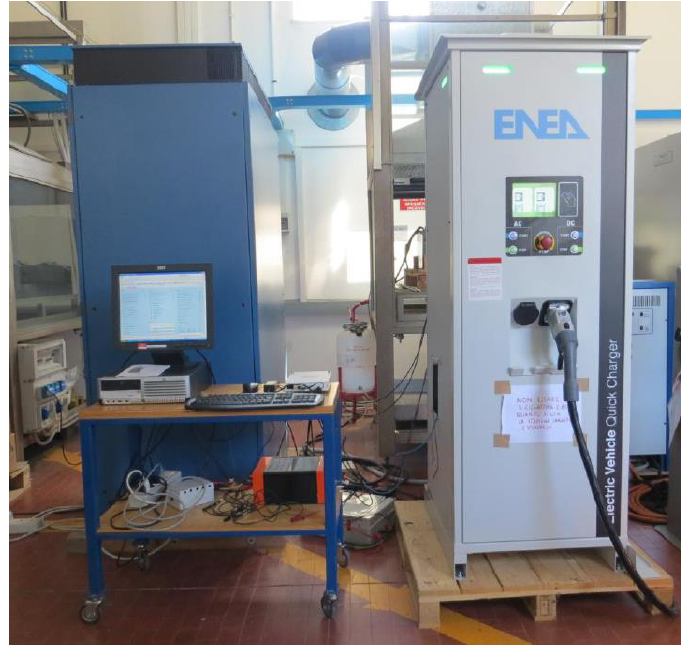
Figure 7. The charging equipment at ENEA labs.